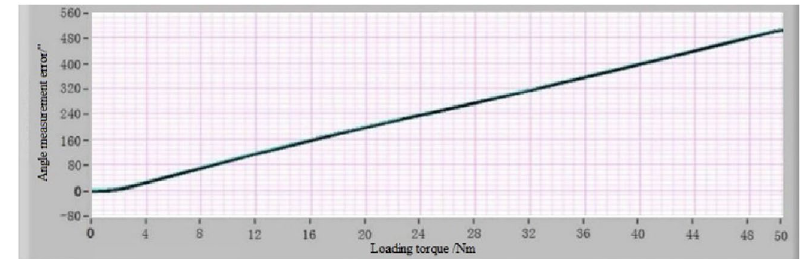
Figure 11. The angle measurement error-loading torque relationship curve of MSIS.